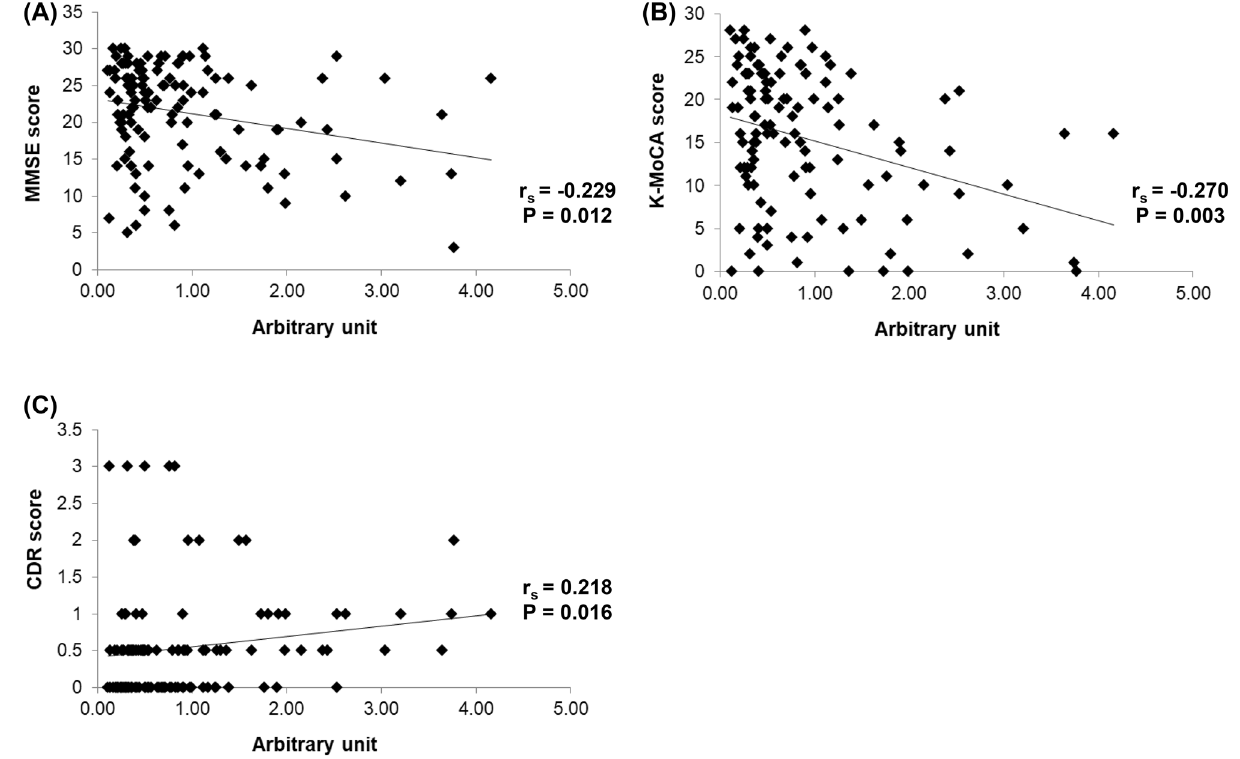
Figure 3. Significant association between anti-ATCAY IgG level and cognitive function. The anti-ATCAY IgG level was negatively correlated with MMSE scores (r s = -0.229, p = 0.012) ( A ), negatively correlated with K-MoCA scores (r s = − 0.270, p = 0.003) ( B ), and positively correlated with CDR scores (r s = 0.218, p = 0.016) ( C ). The correlation was evaluated by Spearman correlation test after excluding the outliers of more than 1.5 × interquartile range